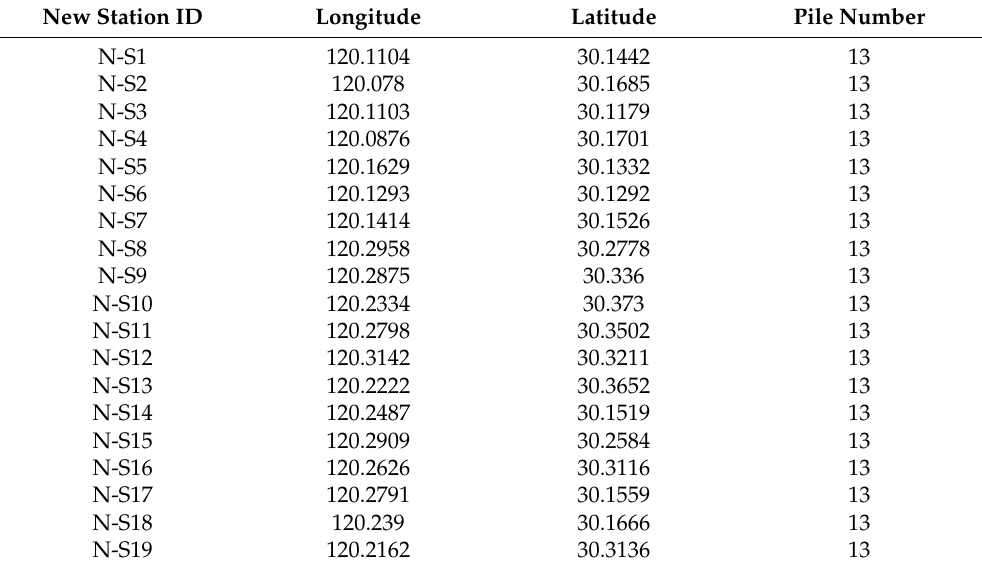
Table 2. The information of the new charging stations. New Station